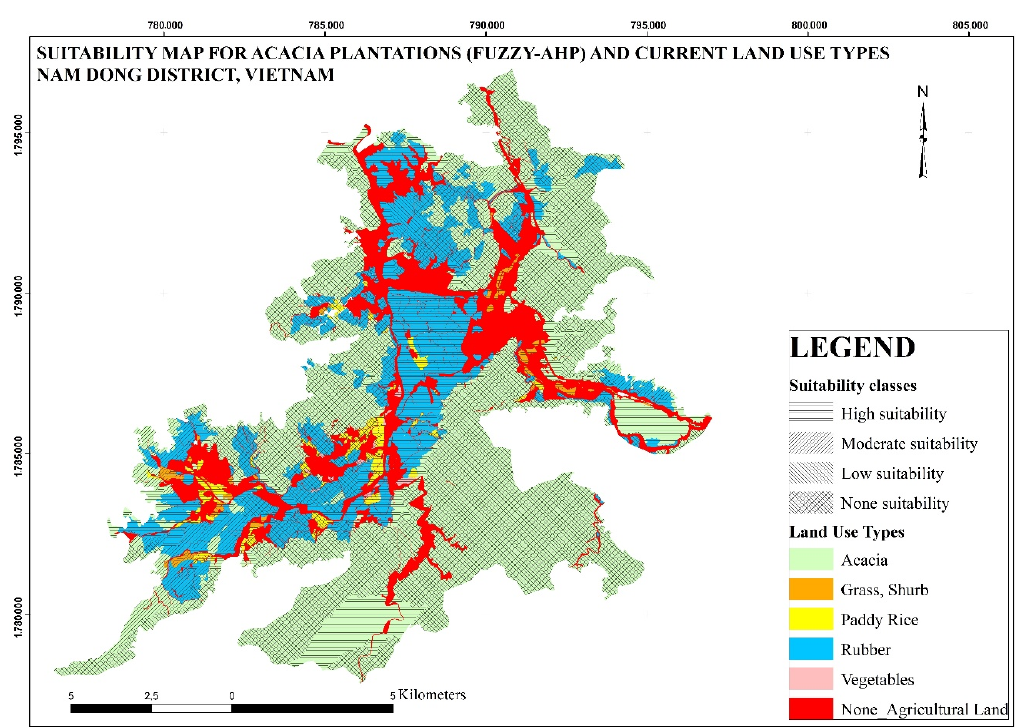
Figure 7. Suitability map for acacia plantation (FAHP method) and current land use types.